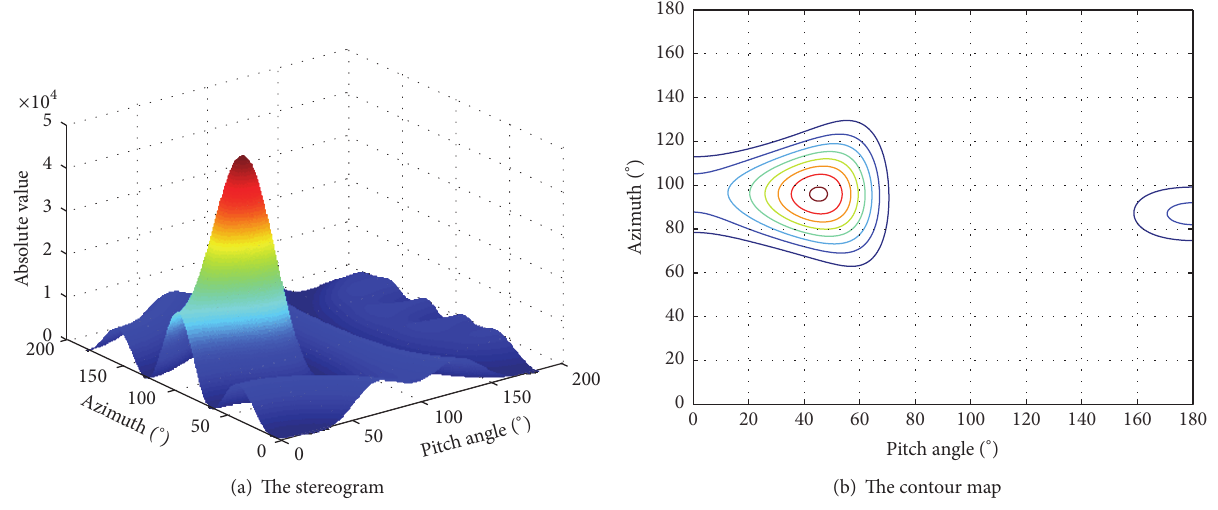
Figure 6: The scatter gram of the absolute value of the inner product in the